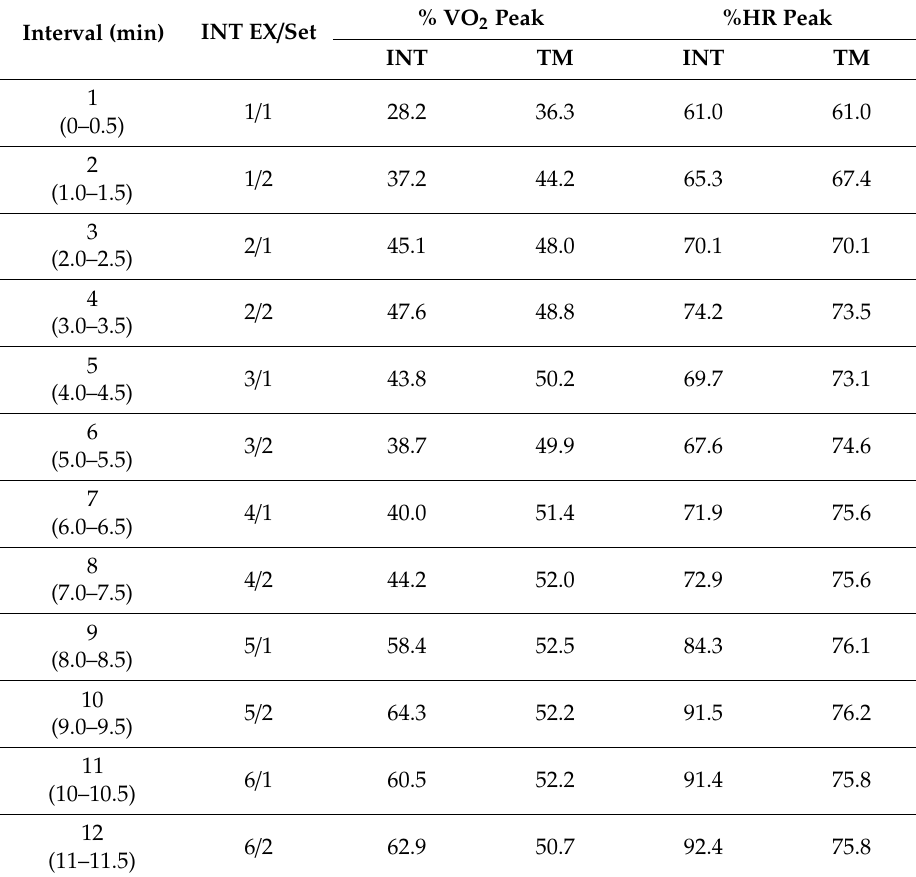
Table 2. Relative cardiometabolic intensity during integrative neuromuscular training (INT) and treadmill (TM) walking intervals.